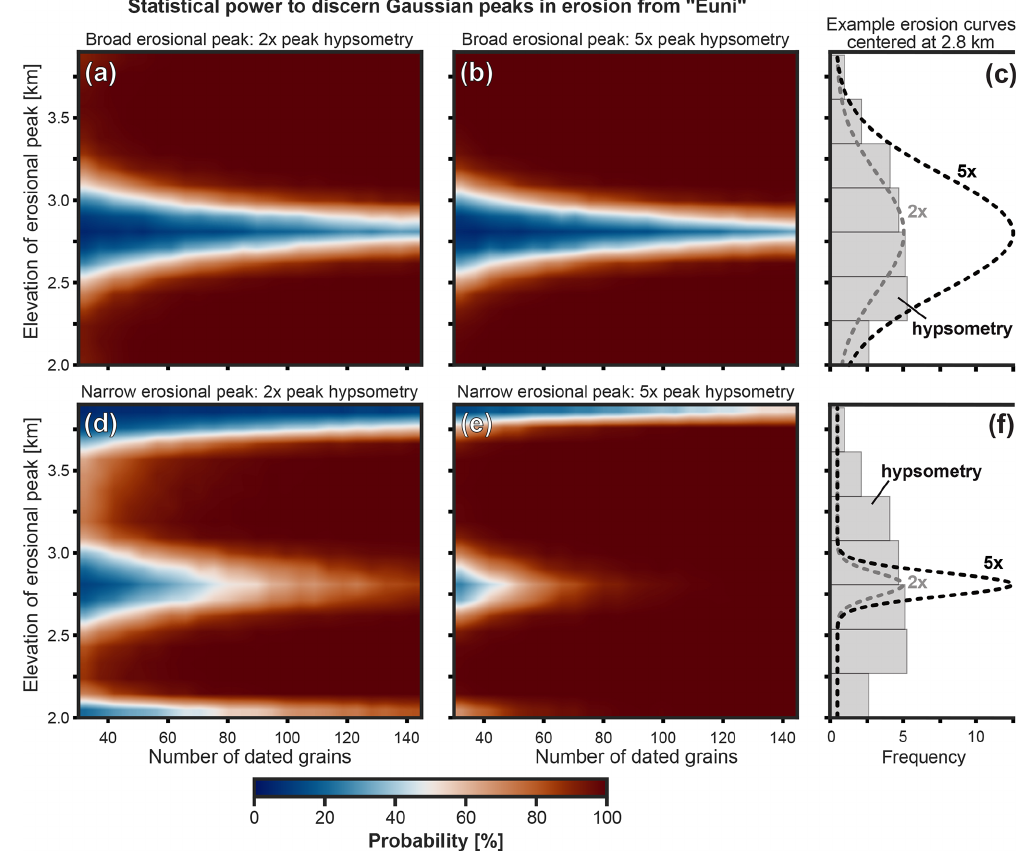
Figure 10. Analysis of statistical power in discerning between the uniform erosion scenario “ E uni ” and scenarios with a broad (a, b) or narrow (d, e) Gaussian peak of erosion as a function of sample size and elevation of the Gaussian peak. The color scale informs the statistical power as a function of the number of grains ( x axis) and the elevation at which the Gaussian peak is centered ( y axis). The catchment hypsometry (c, f) and age–elevation relationship used here are the same as the Inyo Creek data (Stock et al., 2006). (a) Gaussian erosional function with 1 σ = 500m and 2 times the peak prominence of the hypsometric histogram. (b) Gaussian erosional function with 1 σ = 500m and 5 times the peak prominence of the hypsometric histogram. (d) Gaussian erosional function with 1 σ = 100m and 2 times the peak prominence of the hypsometric histogram. (e) Gaussian erosional function with 1 σ = 100m and 5 times the peak prominence of the hypsometric histogram. (c, f) Example erosional functions for peaks centered at 2800m elevation. The reader is referred to Sect. 6 for more